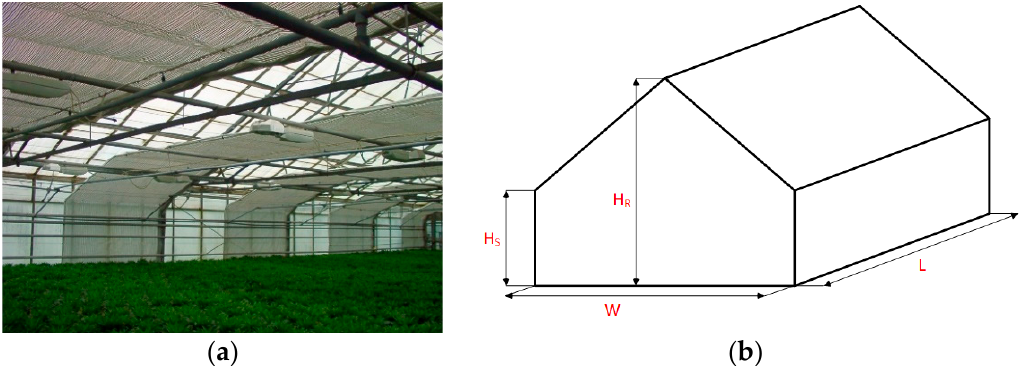
Figure 1. GH under study: ( a ) A view of GH with thermal screen; ( b ) Main dimensions. Based on measurement data, it was possible to determine the actual energy perfor- mance of a GH. Measurements were made in a self-contained GH, which is part of a larger GH facility. This GH facility is located in central Poland, in the town of Skierniewice. The territory of Poland is divided into five climatic zones. Skierniewice is in zone III, which cov- ers more than 50% of the part of Poland. Zones I and II together cover 30% of the territory of Poland. The average annual outside temperatures in zones I, II and III are 7.6 ◦ C, 7.9 ◦ C and 7.7 ◦ C, respectively. The average annual outside temperatures in zones IV and V are lower and amount to 6.9 ◦ C and 5.5 ◦ C, respectively. Therefore, production under cover in Poland is concentrated in zones I–III. Moreover, the analysed GH is fired with coal, which, in Poland, is still the most commonly used fuel in such facilities. The main limitation of the LCA method is the inability to directly compare the results, which are dependent on many factors, i.e., boundary conditions, production strategy and geographical location [30]. Since, in the present paper, different scenarios are analysed in the same facility, the disadvantage related to a geographical location is